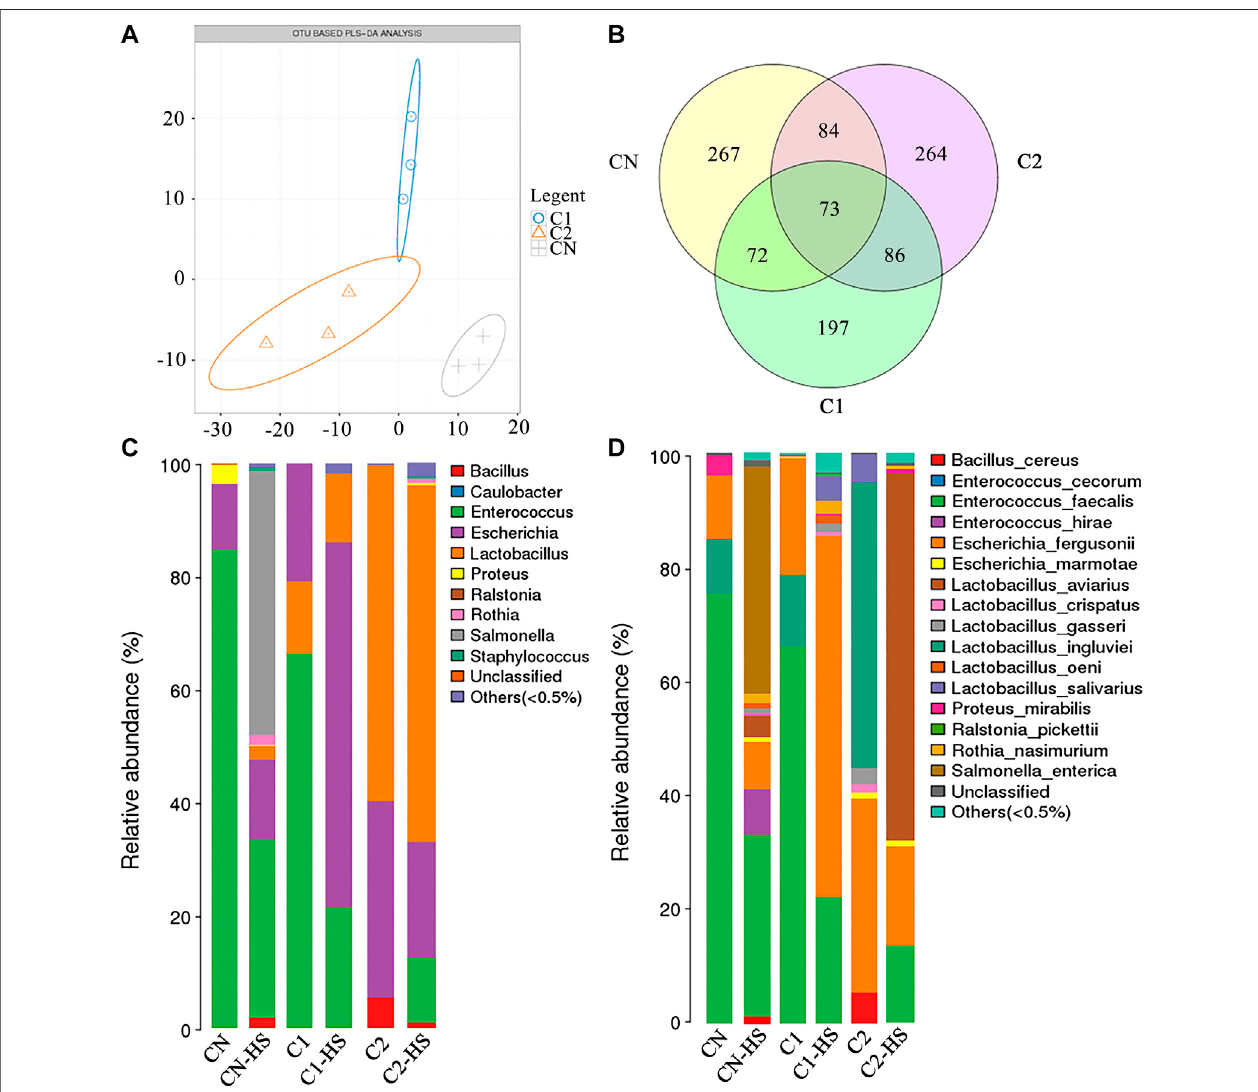
FIGURE 4 | Dietary 1,8-cineole microcapsules alter of gut microbiota. Notes: (A) partial least squares discrimination analysis (PLS-DA) based on abundance of OTU. (B) Venn diagram for OTU. (C) Changes in bacteria genus during the indicated treatment. (D) Changes in bacteria species under indicated treatments. n (cid:2) 6.